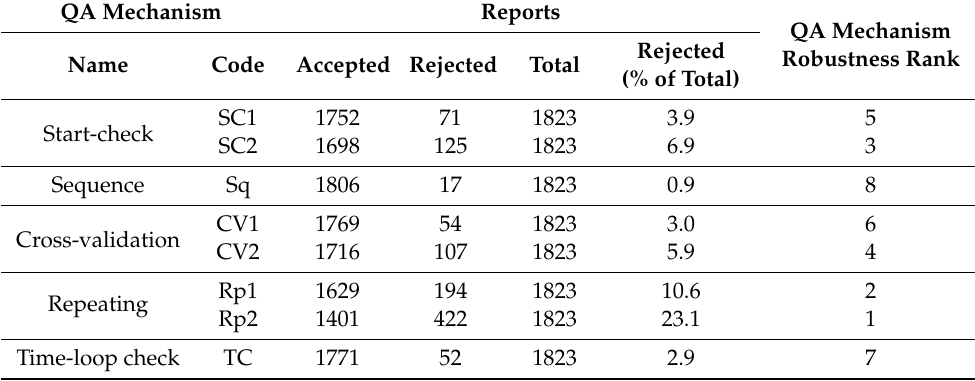
Table 4. QA mechanism robustness.